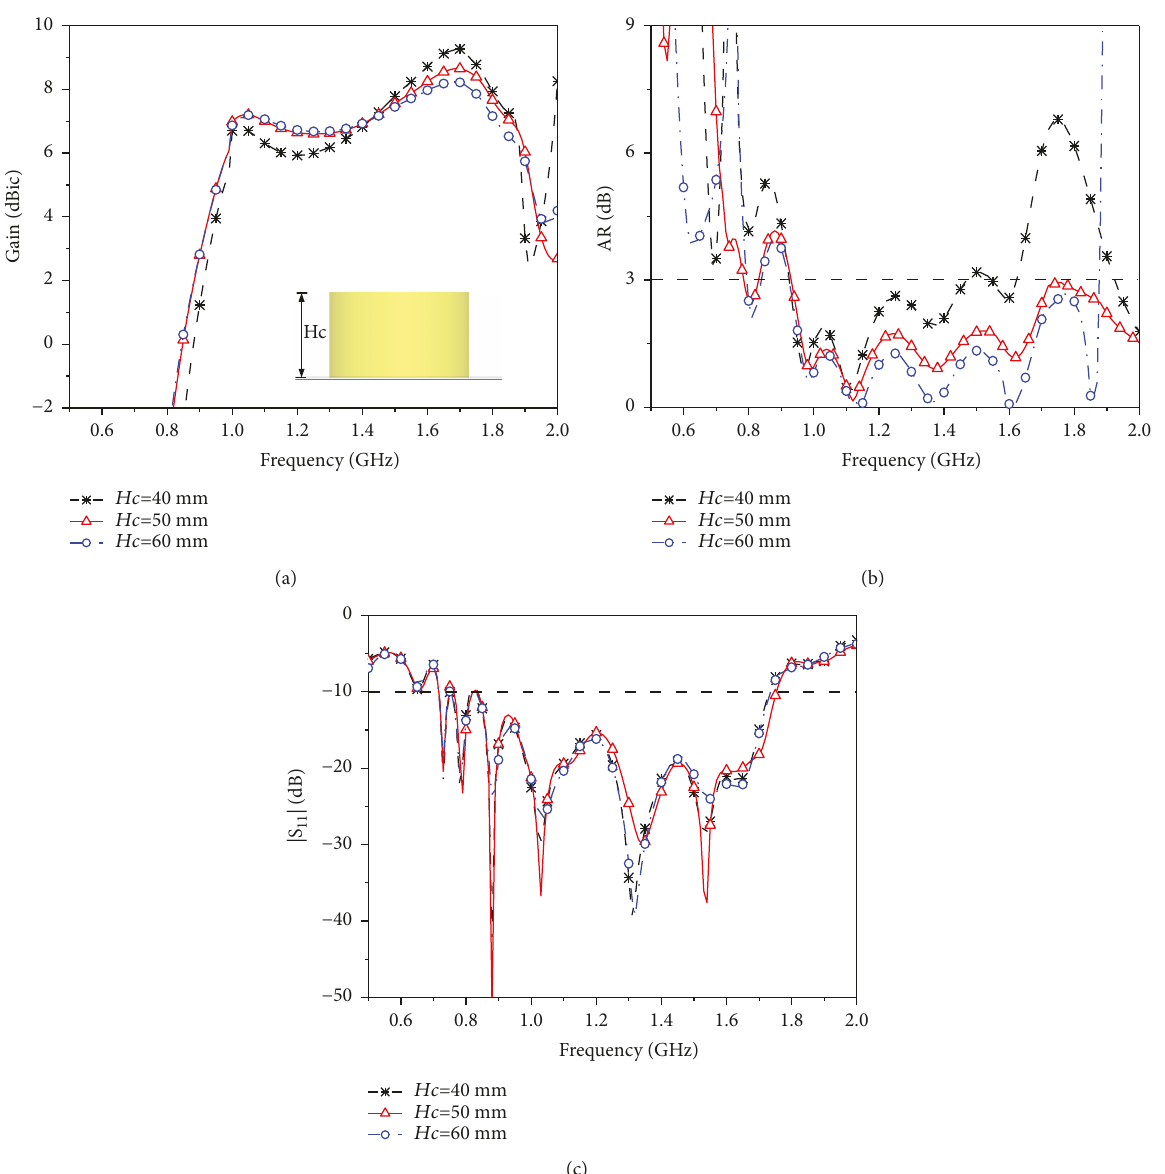
Figure 8: E ff ect of H c on the antenna. (a) Gains and (b) ARs at broadside direction. (c) S 11 s .